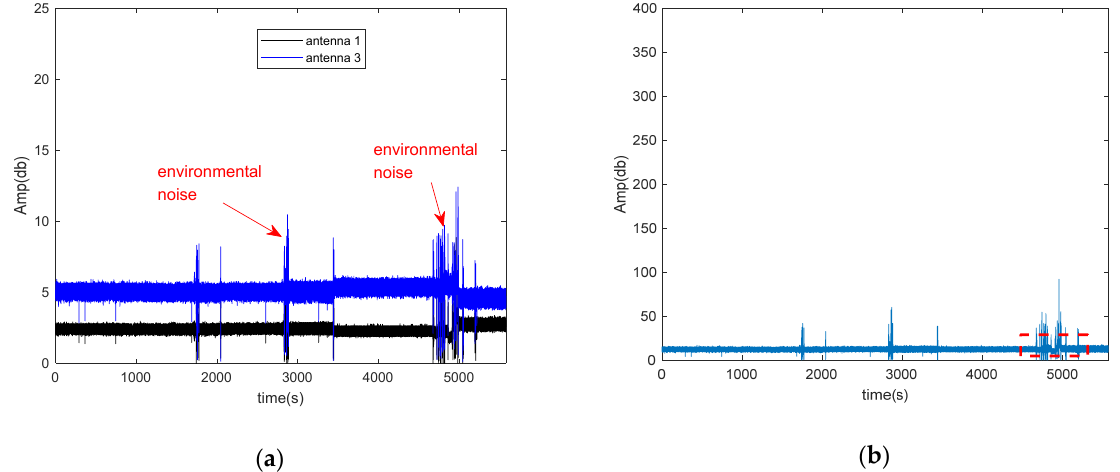
Figure 4. The amplitude of CSI and the conjugate multiplication between the CSI of two antennas after removing the noise of AGC. ( a ) The amplitude of CSI and conjugate multiplication between the CSI of two antennas after removing the noise of AGC in the silence environment; ( b ) the amplitude of conjugate multiplication between the CSI of two antennas after removing the noise of AGC.